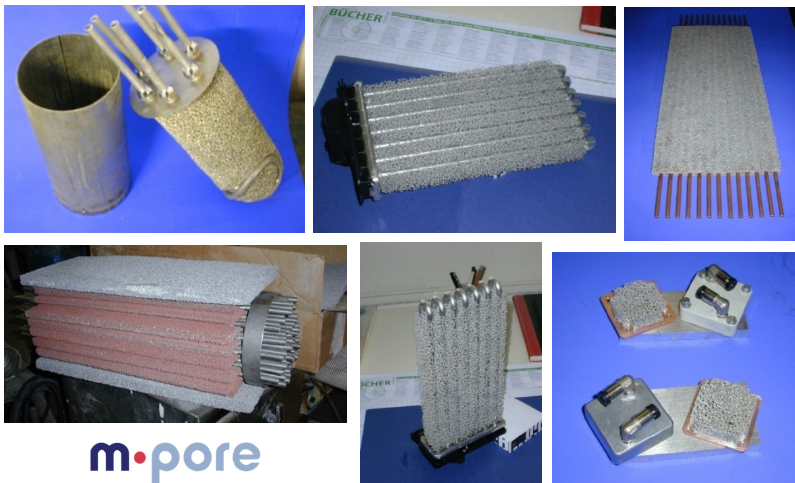
Figure 12. Diverse types of heat exchangers based on Al ‐ and Cu ‐ foams (courtesy of M ‐ pore and Mayser GmbH).